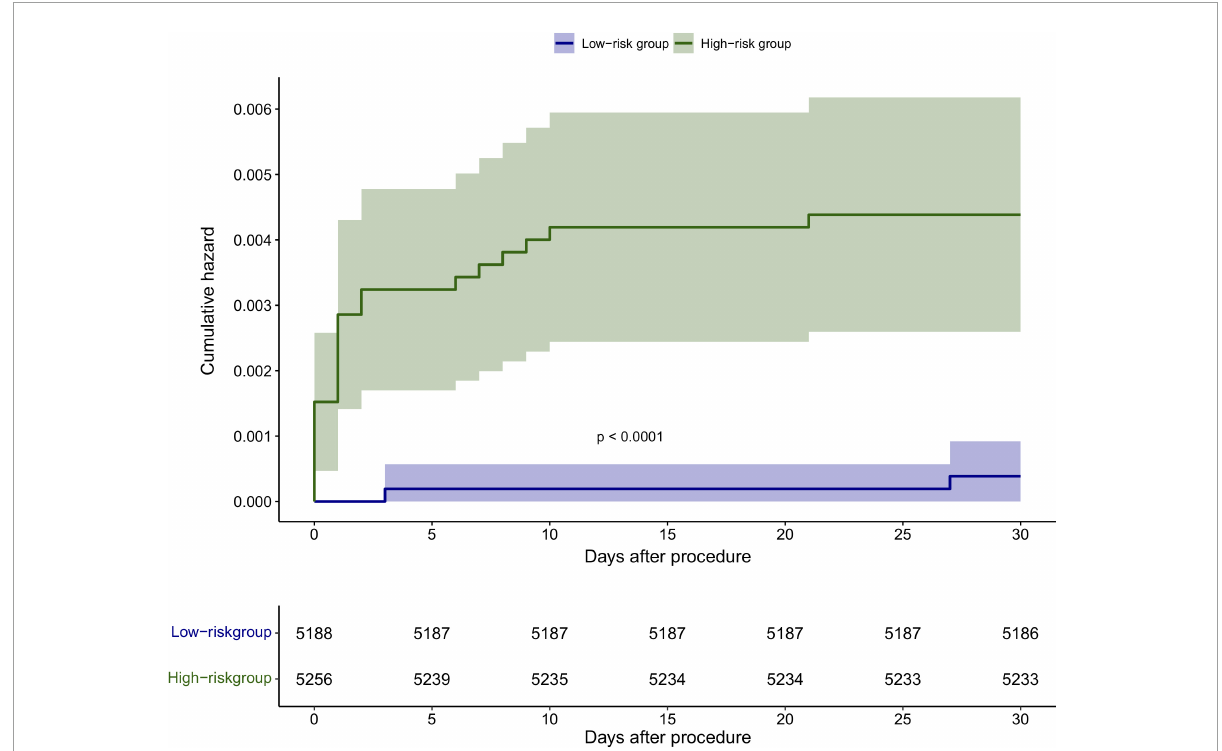
FIGURE6 Kaplan–Meier analysis of the 30-day mortality based on the median score < 4 and ≥ 4 in the cohort.